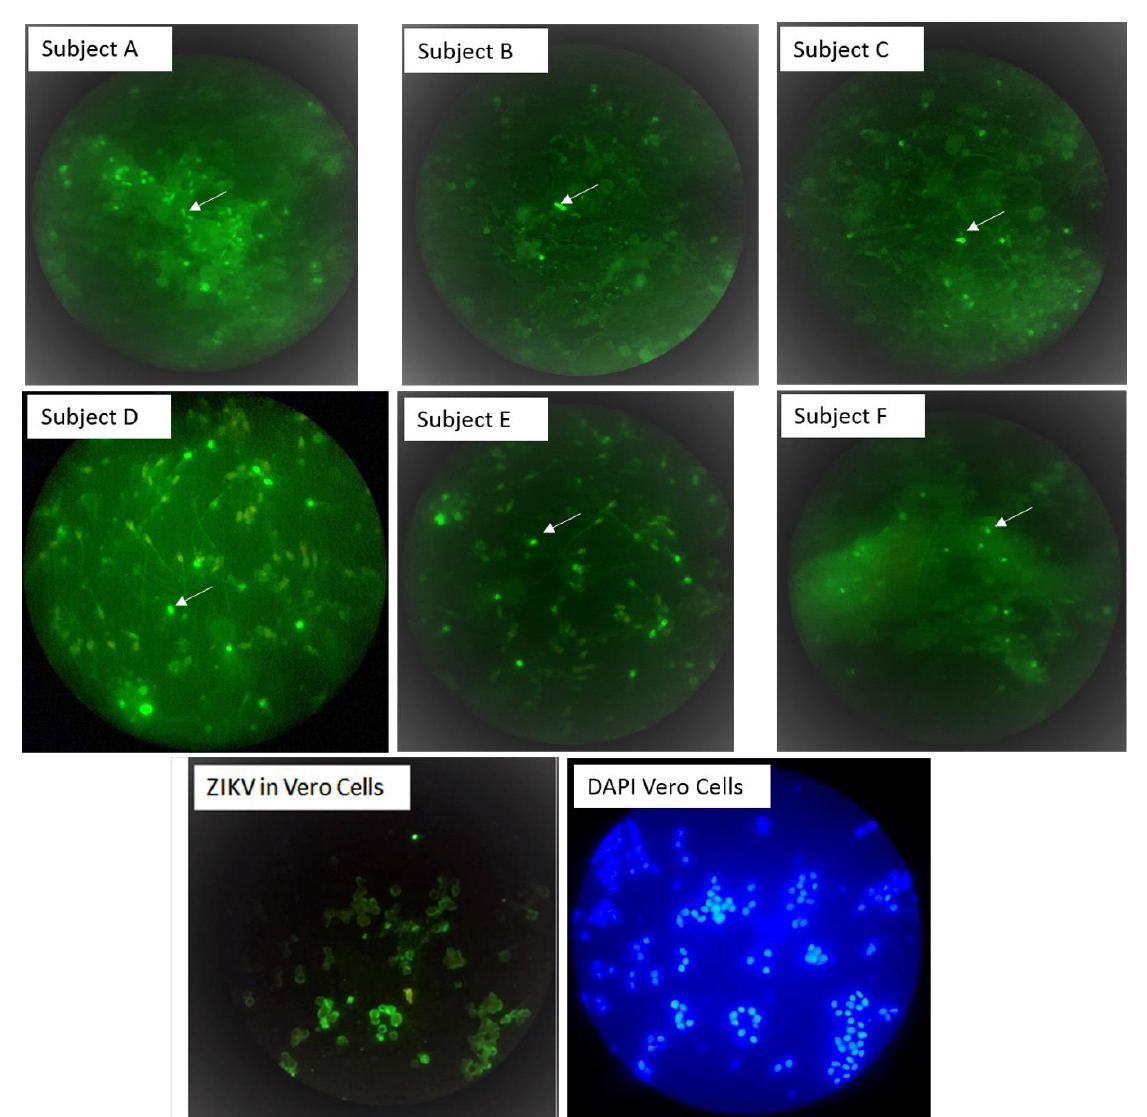
Figure 1. Zika virus binds to sperm cells. Sperm IF staining with the flavivirus 4G2 monoclonal antibody and Alexa fluor-488 conjugate (green). Subjects A, B and C were patients with Zika symptoms, and subjects D, E and F were asymptomatic controls. A sample was considered positive if at least one cell with sperm-like morphology contained bright green spots (see white arrows) after scanning ten high power fields with 40X objective in duplicates samples. The image of ZIKV in vero was performed to evidence that 4G2 is capable of recognizing ZIKV. All images were taken with 40× objective.